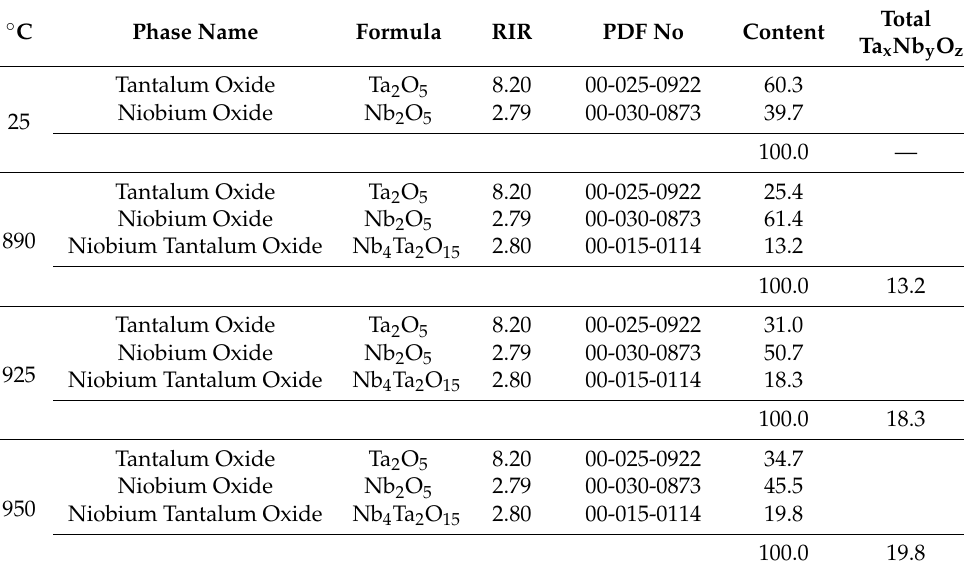
Table 7. Quantitative phase analysis results (WPF) from the high-temperature XRD scans of a 30 mol%